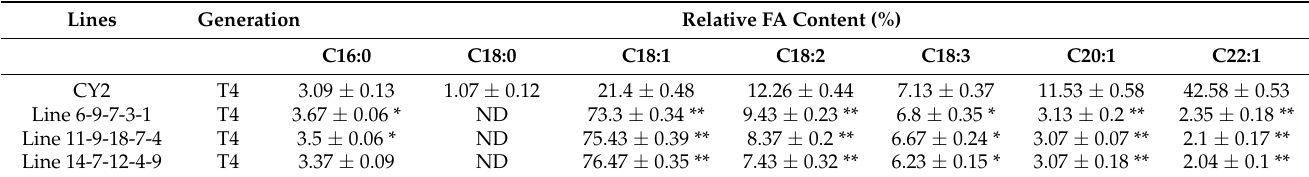
Table 3. Relative FA content in seeds of the edited lines.